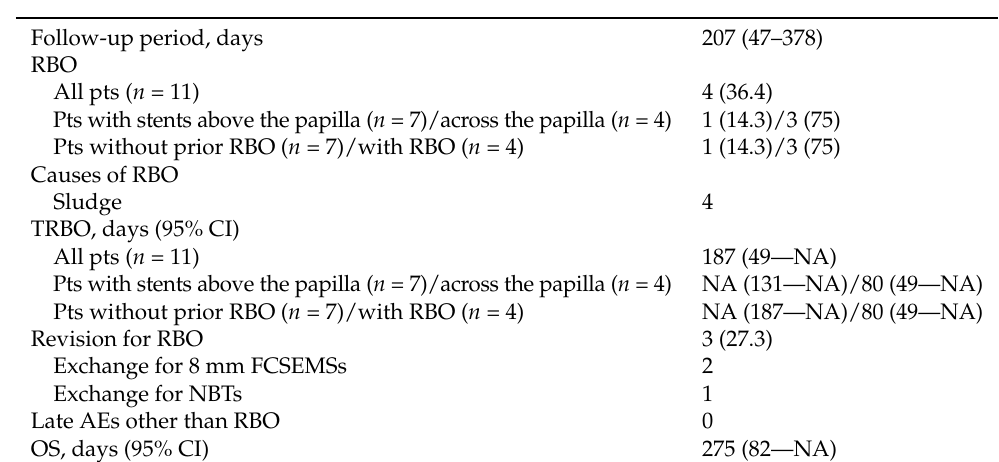
Table 3. Long-term outcomes.